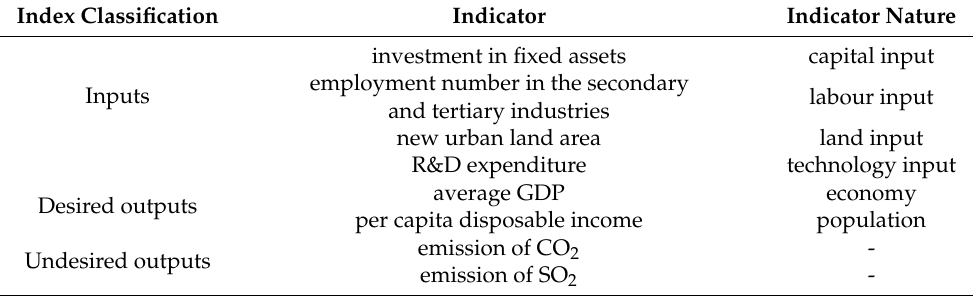
Table 2. Index system of